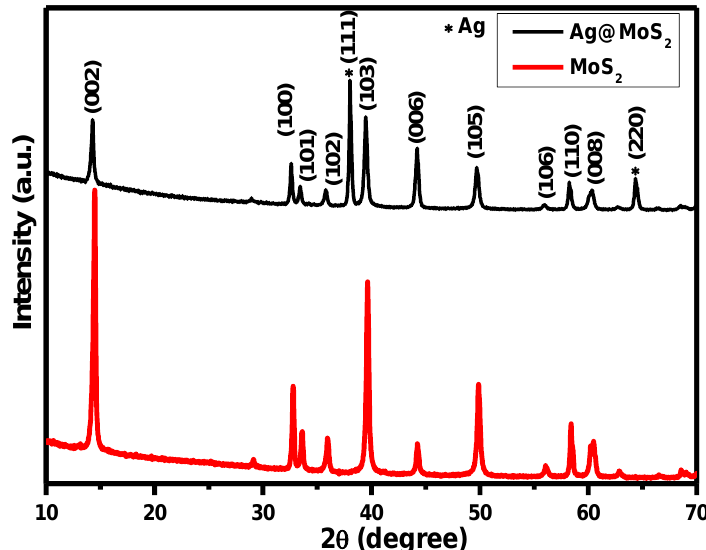
Figure 1. X-ray diffraction patterns of the MoS 2 and Ag-MoS 2 composites . The different types of bonding, vibrational modes, and defects were analyzed using Raman spectroscopy. Figure 2 displays the Raman spectra of MoS 2 and Ag-MoS 2 compo- site. For MoS 2 , the major peak positioned at 379.43 cm −1 corresponds to E12g mode, which is associated with the in-plane opposite vibration of two S atoms [23]. The peaks were observed at 821.13 and 991.61 cm −1 due to the oxidation of MoS 2 by laser irradiation, lead- ing to the formation of MoO 3 , which presents the vibrational energy of MoO 3 . Other major peaks found at 284.23 and 821.13 cm −1 are associated with MoS 2 . In the case of the Ag- MoS 2 composite, the peaks found at 1066.33, 1301.89, and 1536.68 cm −1 are associated with Ag [24]. So, Raman investigation confirms the formation of a Ag-MoS 2 composite.